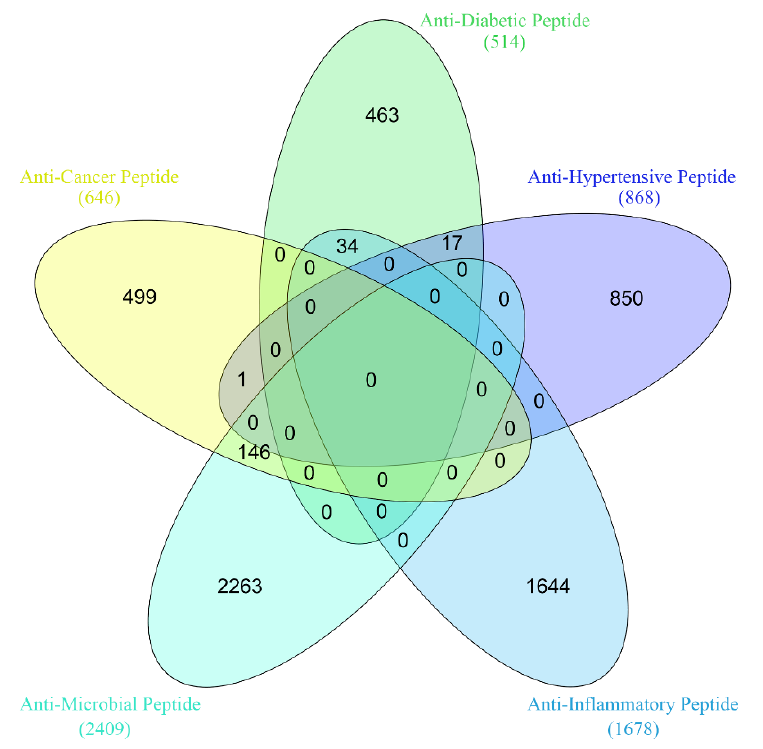
Figure 4. Venn diagram of the dataset.